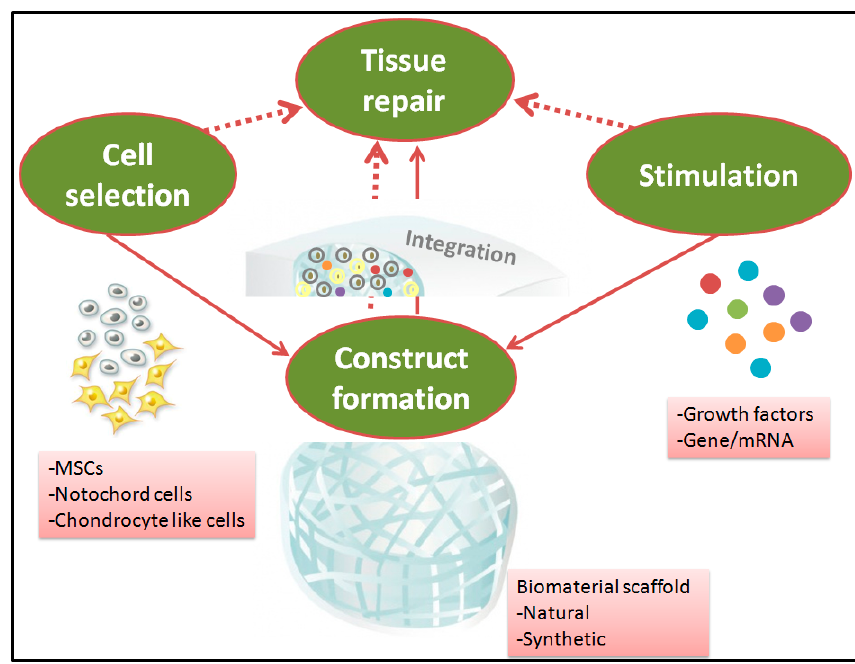
Figure 3. Synergetic tissue engineering strategies for nucleus pulposus repair.